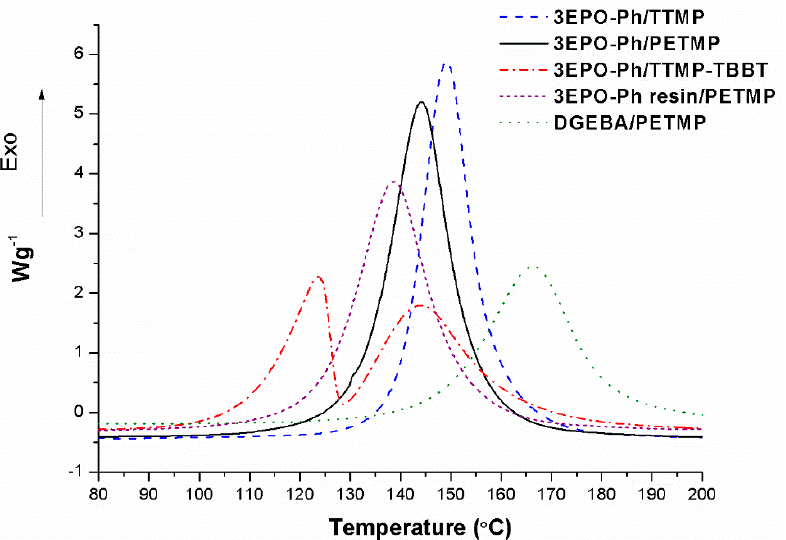
Figure 5. Curing exotherms of the stoichiometric 3EPO-Ph/thiol formulations with. 1 phr of the BG as the catalyst and curves of the 3EPO-Ph resin and DGEBA, both with PETMP.